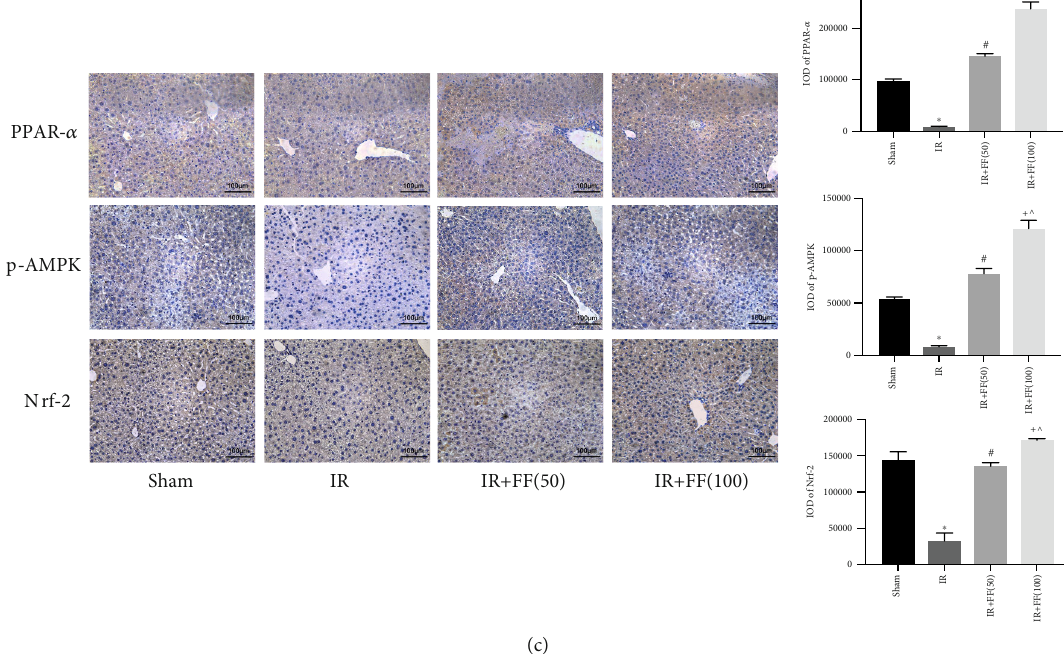
Figure 5: The protective e ff ect of feno fi brate during hepatic IR injury is closely related with the activation of PPAR- α . (a) Relative PPAR- α and p-AMPK mRNA levels were determined by qRT-PCR. (b) Western blot analysis of AMPK, p-AMPK, PPAR- α , and Nrf-2 levels. The western blot results were quanti fi ed with ImageJ 8.0 software. (c) Levels of p-AMPK, PPAR- α , and Nrf-2 in liver tissues at 8 hours after reperfusion are shown by immunohistochemical staining (200x). Final evaluations were made using Image-Pro Plus 6.0 software to calculate the IOD of the positive staining area. Data are presented as mean ± SD ( n = 6 ; ∗ P < 0 : 05 for IR vs. sham; # P < 0 : 05 for IR+FF (50) vs. IR; + P < 0 : 05 for IR+FF (100) vs. IR; ^ P < 0 : 05 for IR+FF (50) vs. IR+FF